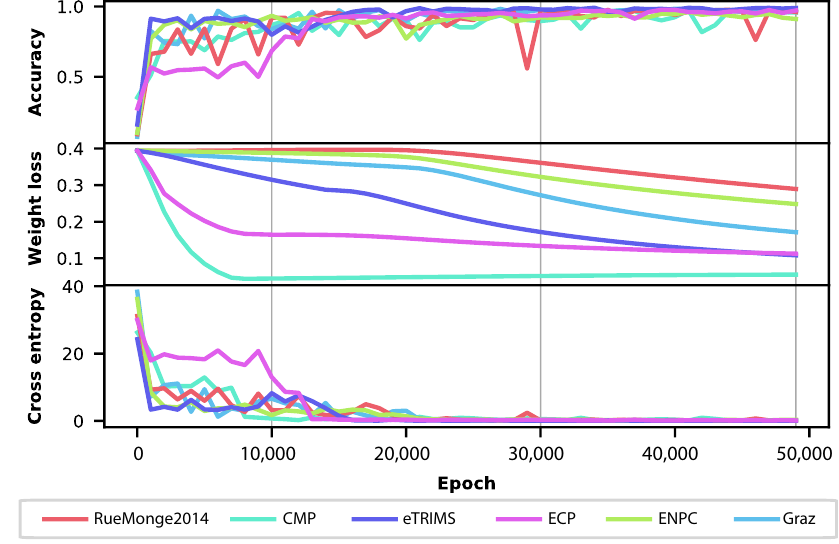
Figure 4. Training result for all